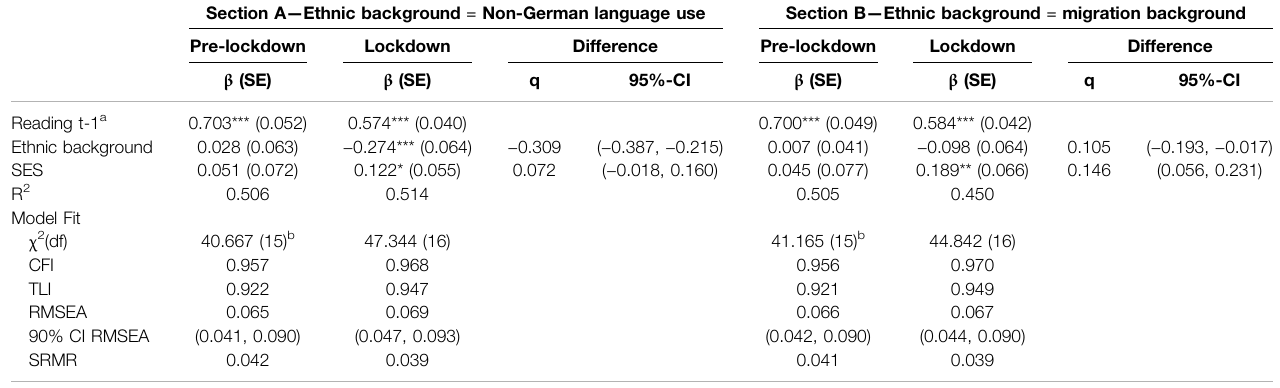
TABLE 2 | Results of SEM for research question